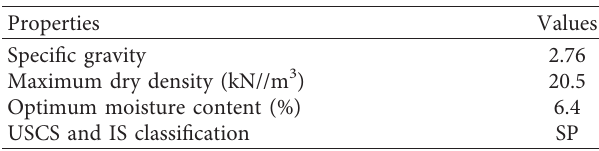
Table 2: Properties of used sand.